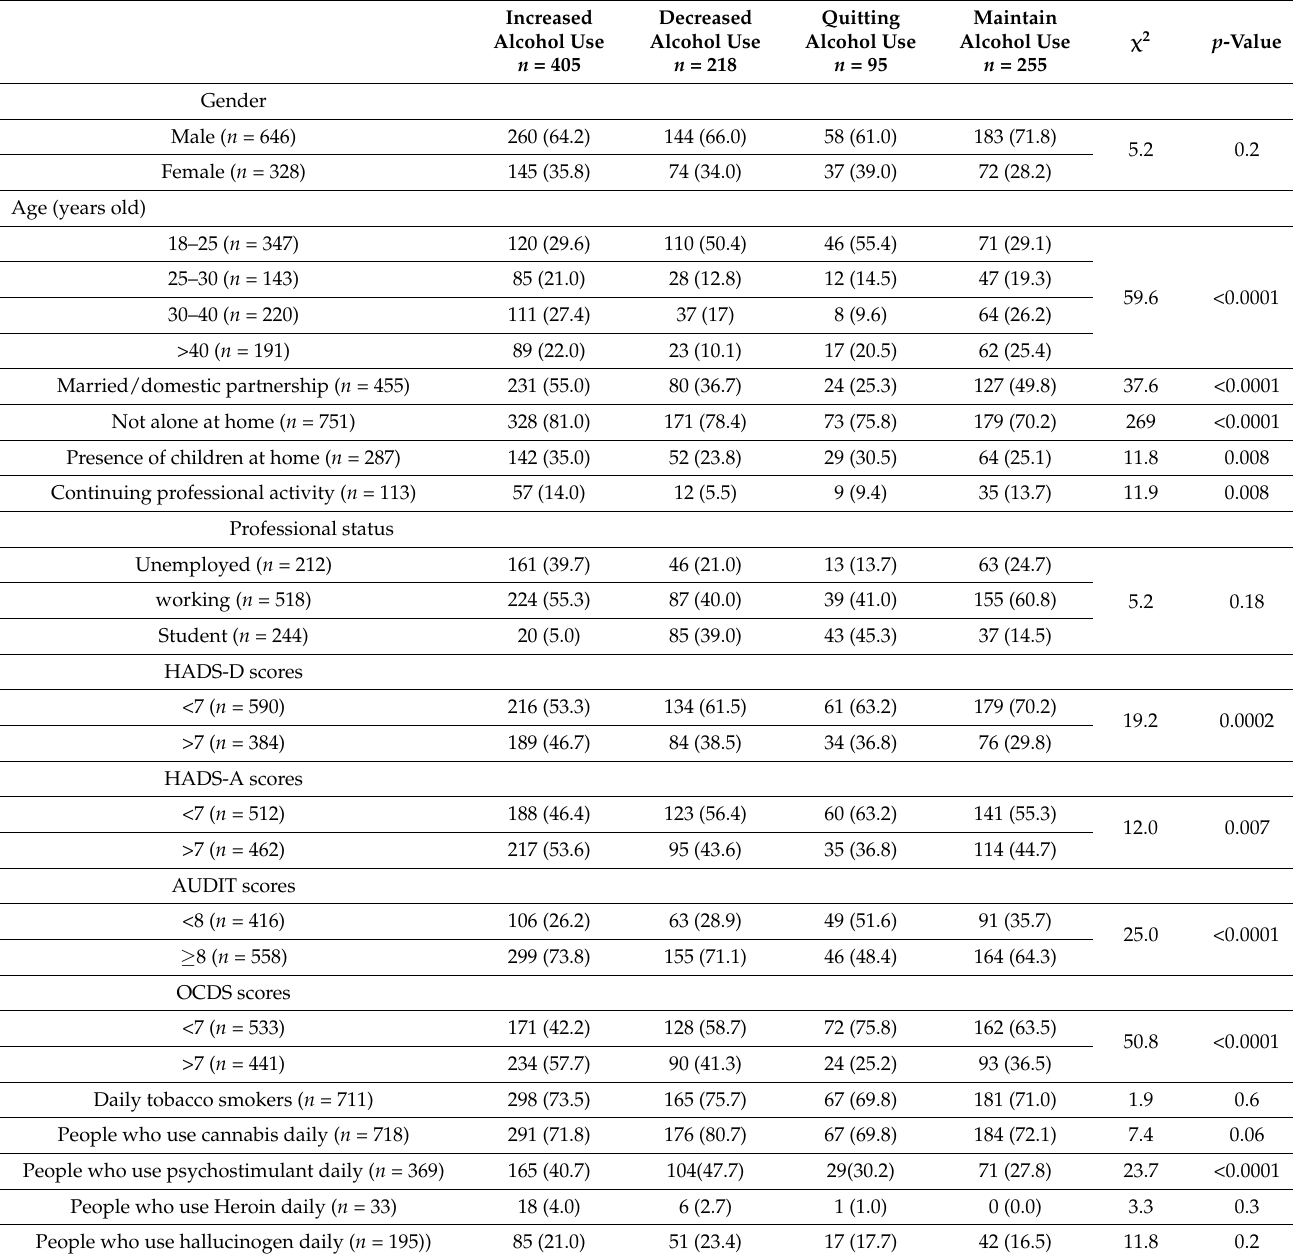
Table 2. Prevalence of increase, decrease, quitting, and maintaining alcohol use based on demographic variables n